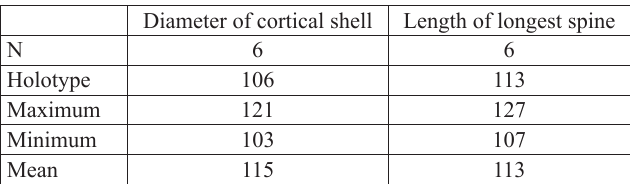
Table 2. Dimensions (in μ m) of Thurstonia ? robusta Cifer sp. nov. N, number of specimens